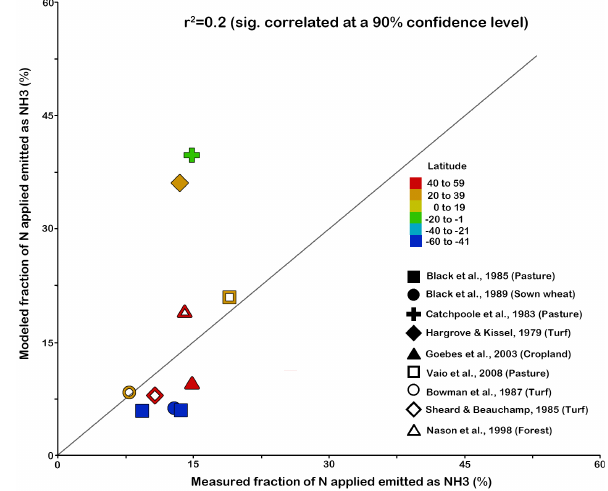
Figure 2. Comparison of model to measurements for percentage of nitrogen lost as NH 3 emissions from manure for a range of studies (see Table S1). Symbol color indicates temperature at which the emissions occurred; shape gives the study.